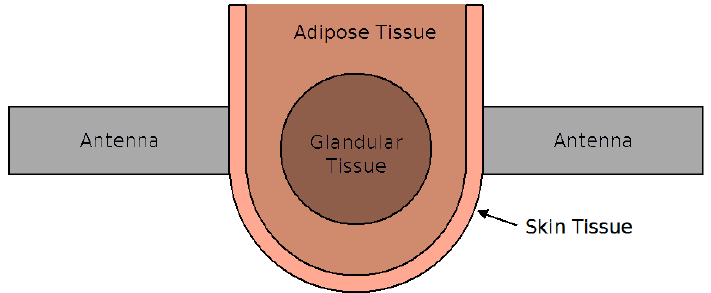
Figure 2. A block diagram of the transmission system, shown in light grey, and a breast model included as the